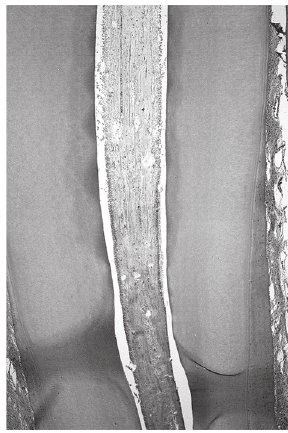
Figure 5. Group II (collagen/hydroxyapatite). Middle third with fibrous pulp tissue and severe hemorrhage. HE; magnification X40.